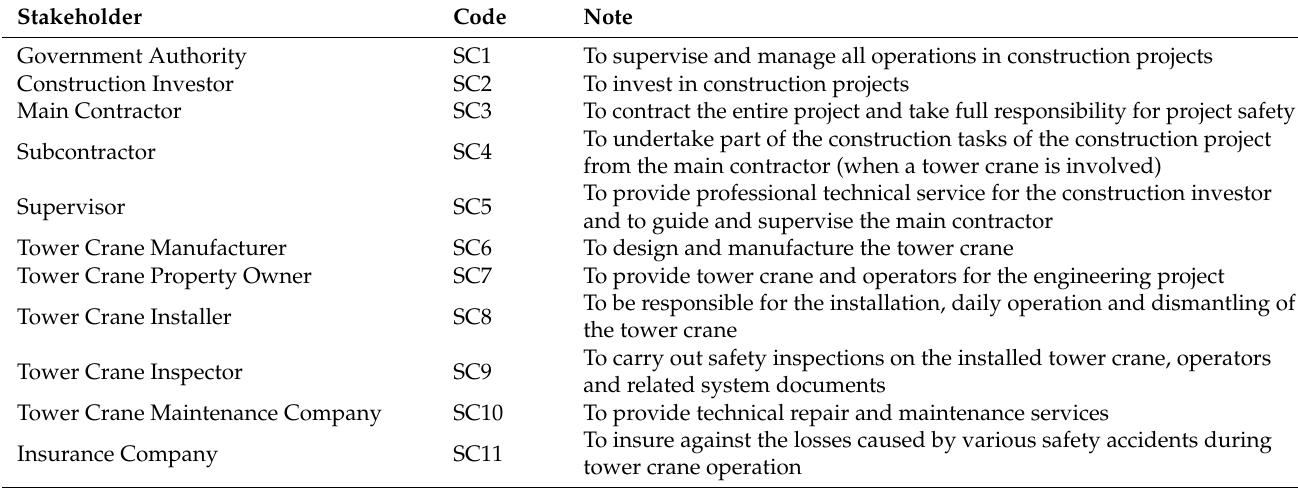
Table 2. Stakeholders in the collaborative governance of tower crane